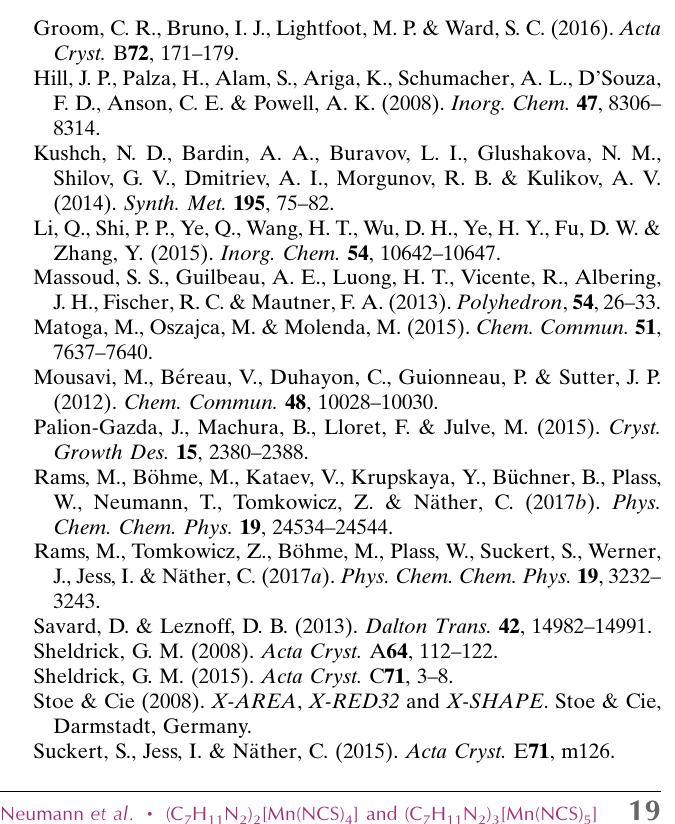
Table 5 Experimental details. Crystal data Chemical